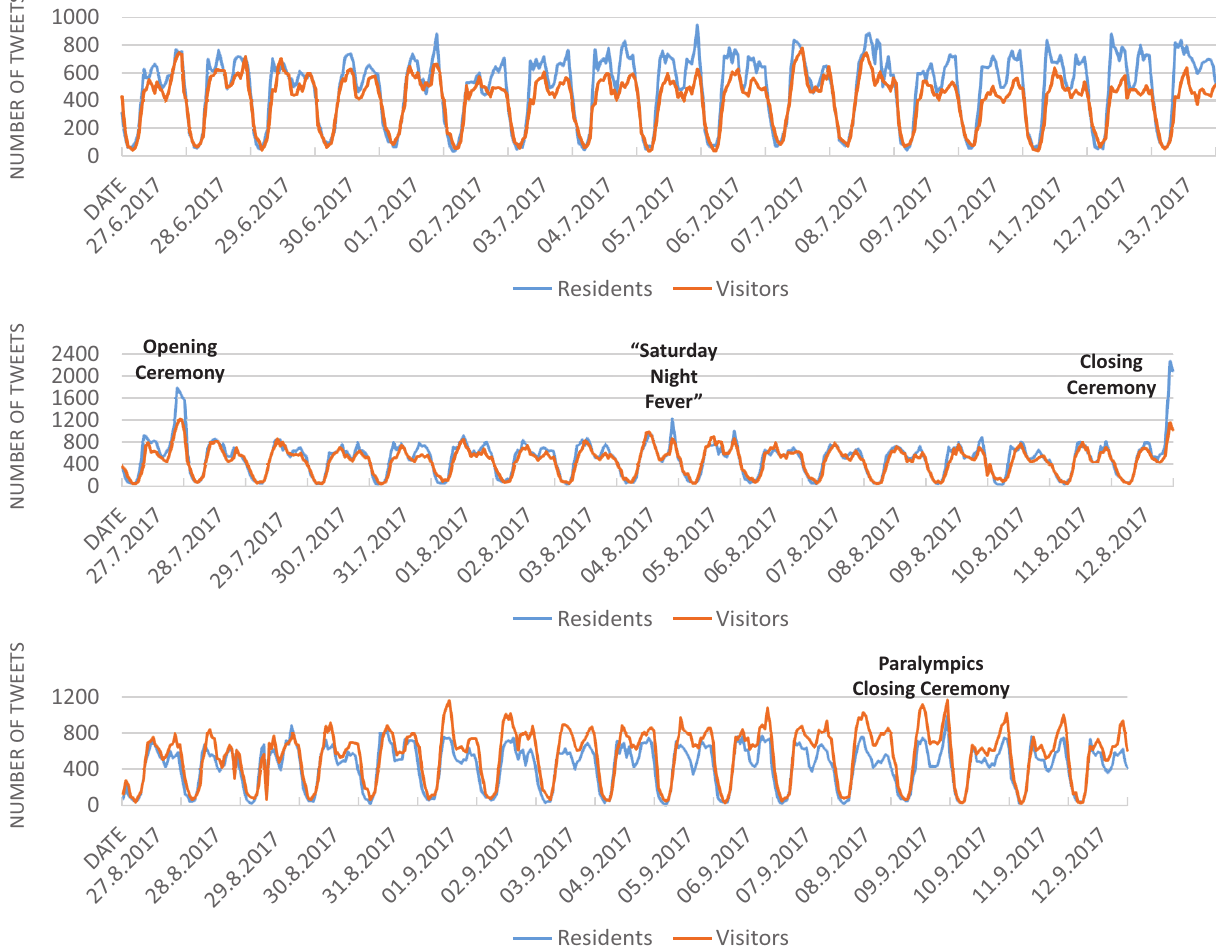
Figure 10. Residents and visitors tweeting behavior per hour for the three temporal